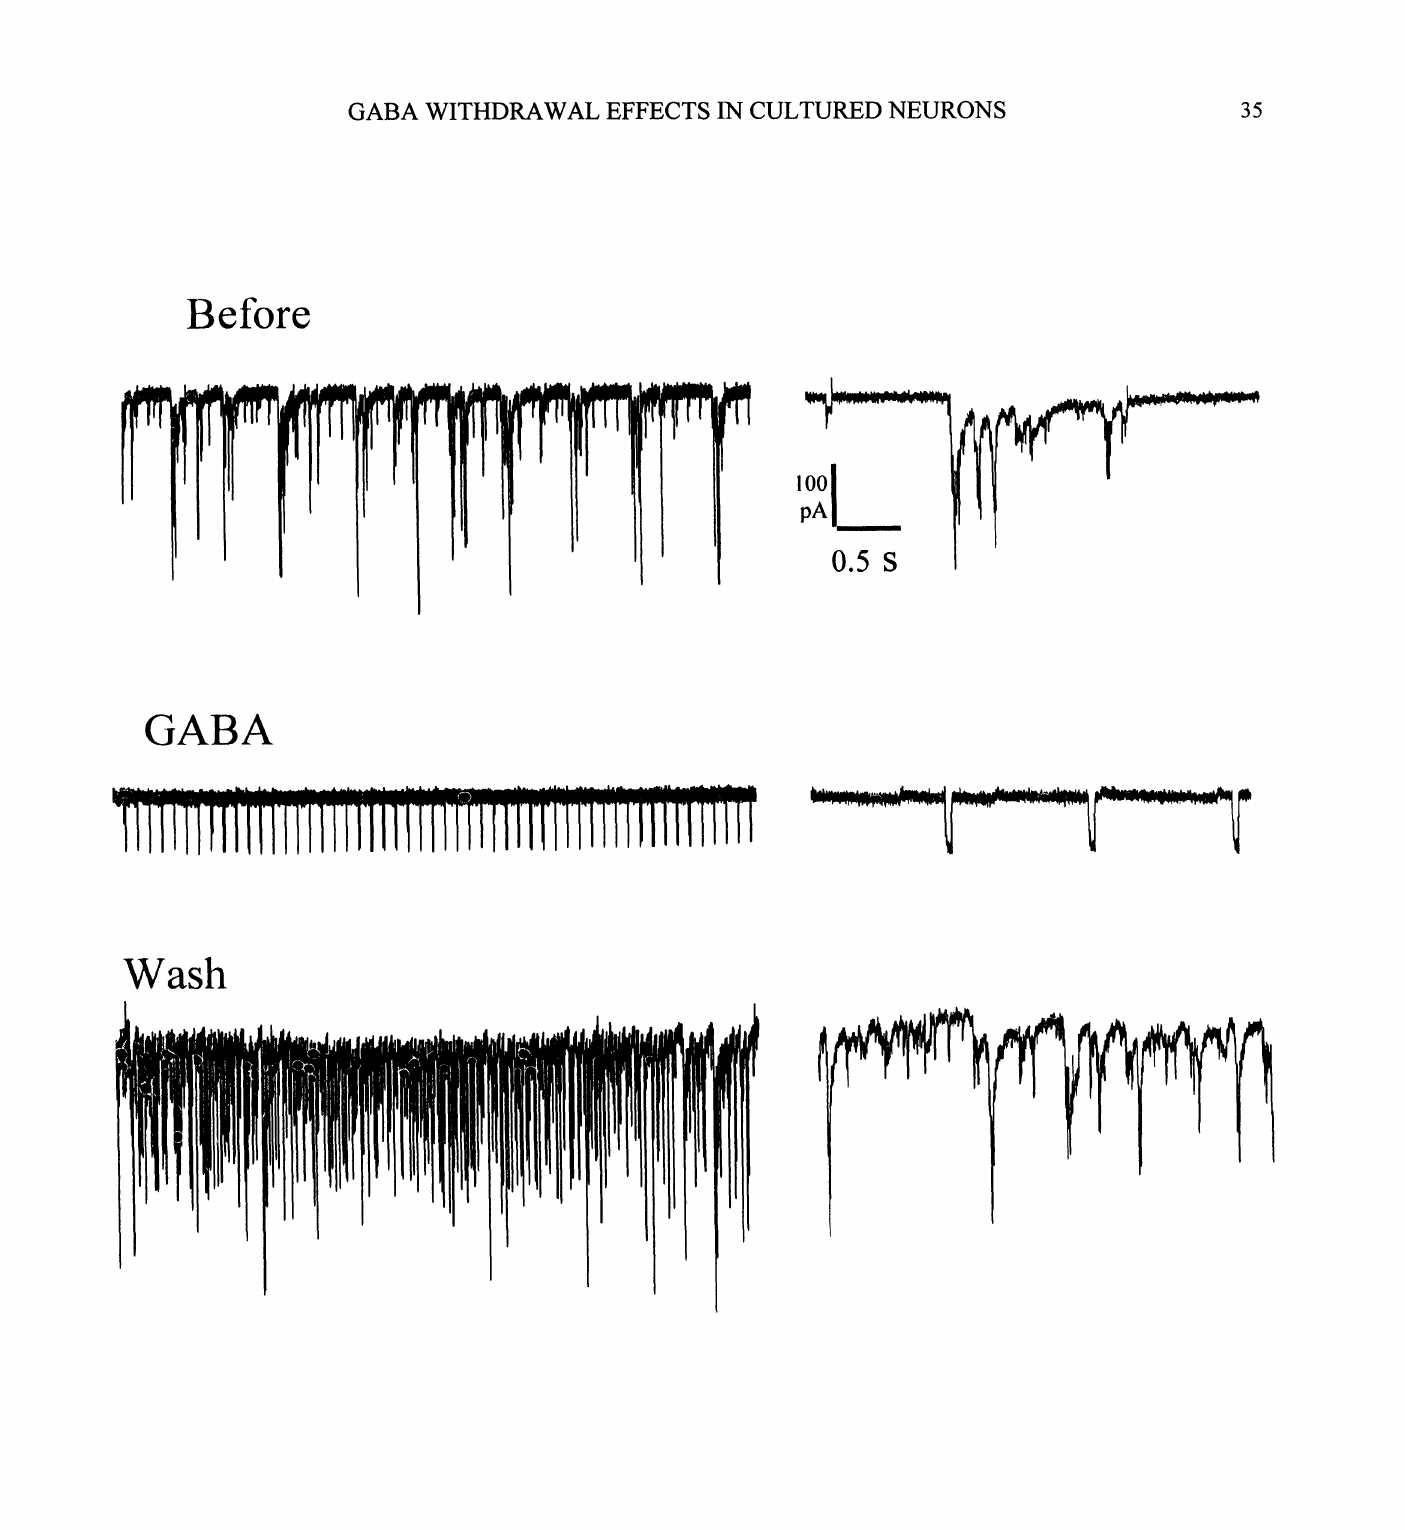
Fig. 2: Spomaneous activity recorded from a patch-clamped hippocampal neuron growing in culture for 3 weeks. Cell clamped at-60mV, and negative voltage commands are applied through the membrane to estimate input conductance of the cell. Left, minute record, right an expanded record to show a typical burst of synaptic currents, and a preceding current response to voltage command. Current scale same for all, time scale only for the right, expanded records. During exposure to 50gM GABA, middle trace, there is complete suppression of synaptic current, and a marked increase in membrane conductance. Bottom, following washout of GABA, EPSCs lost their bursting properties, and a continuous barrage of synaptic currents is